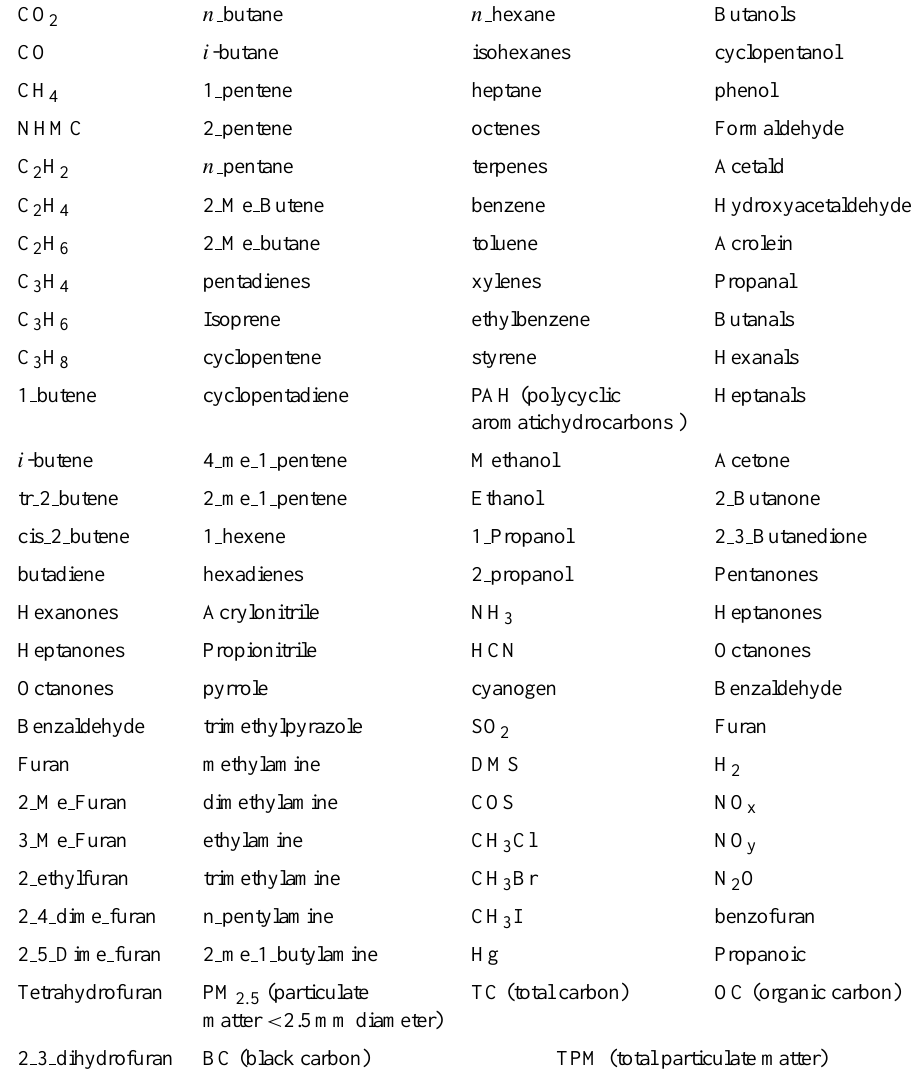
Table 2. List of species available within the PREP-CHEM-SRC system for biomass burning